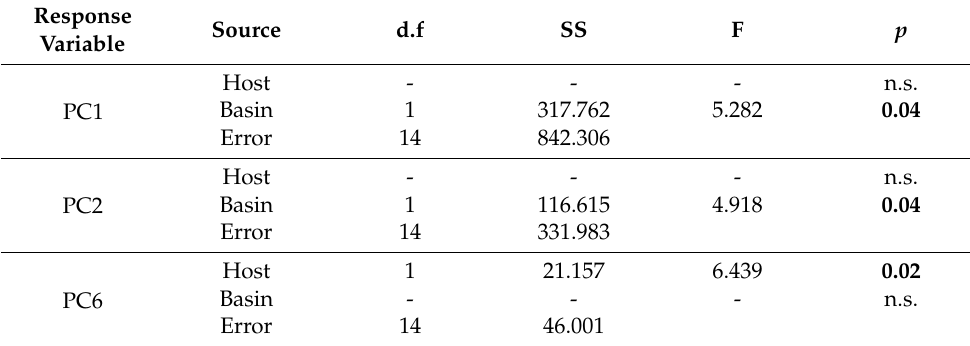
Table 4. Results of general linear models (GLMs) of the principal components (PCs) obtained from the COI haplotype frequencies in Margaritifera margaritifera populations from the White and Baltic Sea basins, utilizing Salmo salar or S. trutta as host-fish. Only models with statistically significant differences ( p < 0.05, marked in bold) are